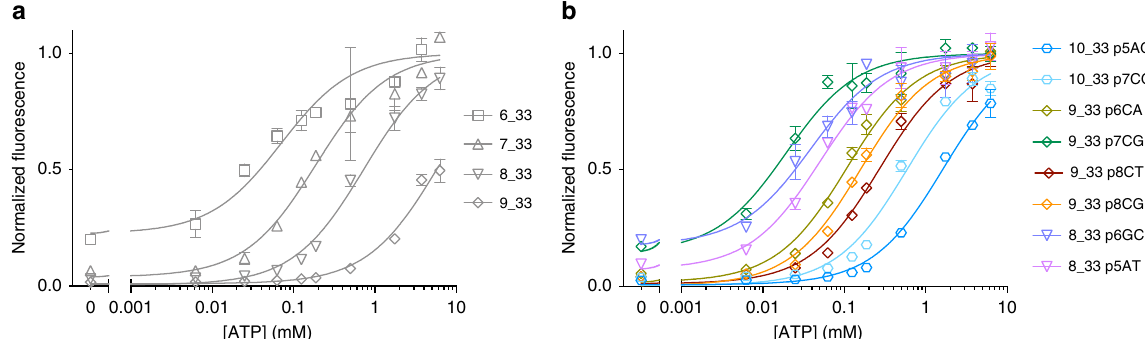
NATURE COMMUNICATIONS| (2019) 10:5079